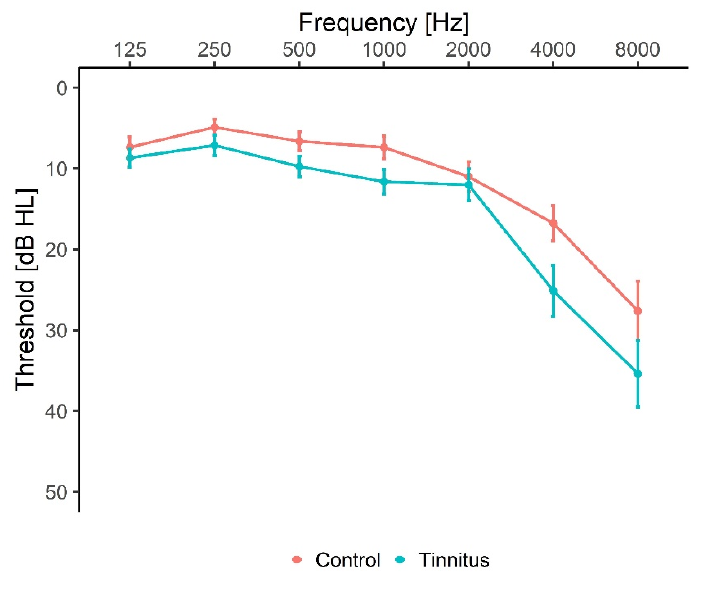
Figure 1. Average audiogram. Hearing thresholds were measured from 125 Hz to 8 kHz. Results were averaged for the left and right ear and shown with mean ± SEM. The red line is the average for the control group, while the blue line is the average threshold for the tinnitus group.